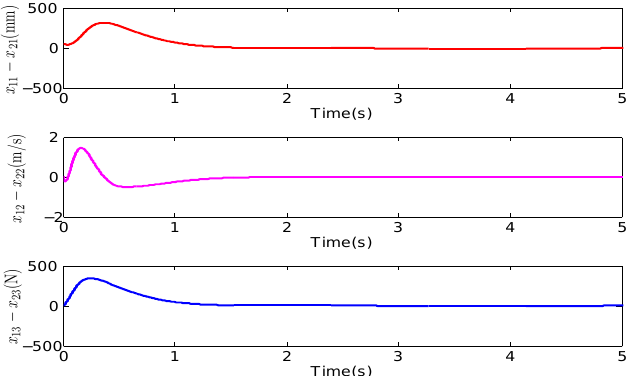
x 21 (the red line) —the − x 23 (the blue line) −